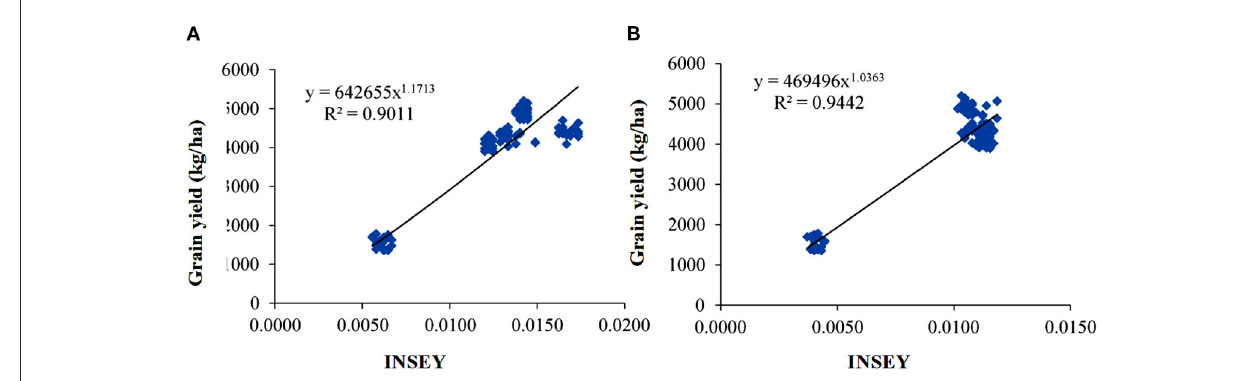
FIGURE1 *GY–INSEY relationship at (A) : 45 and (B) : 65 DAS. *2017–2018 and 2018–2019 station data and 2019–2020 farmers’ field data were used in developing the relation.